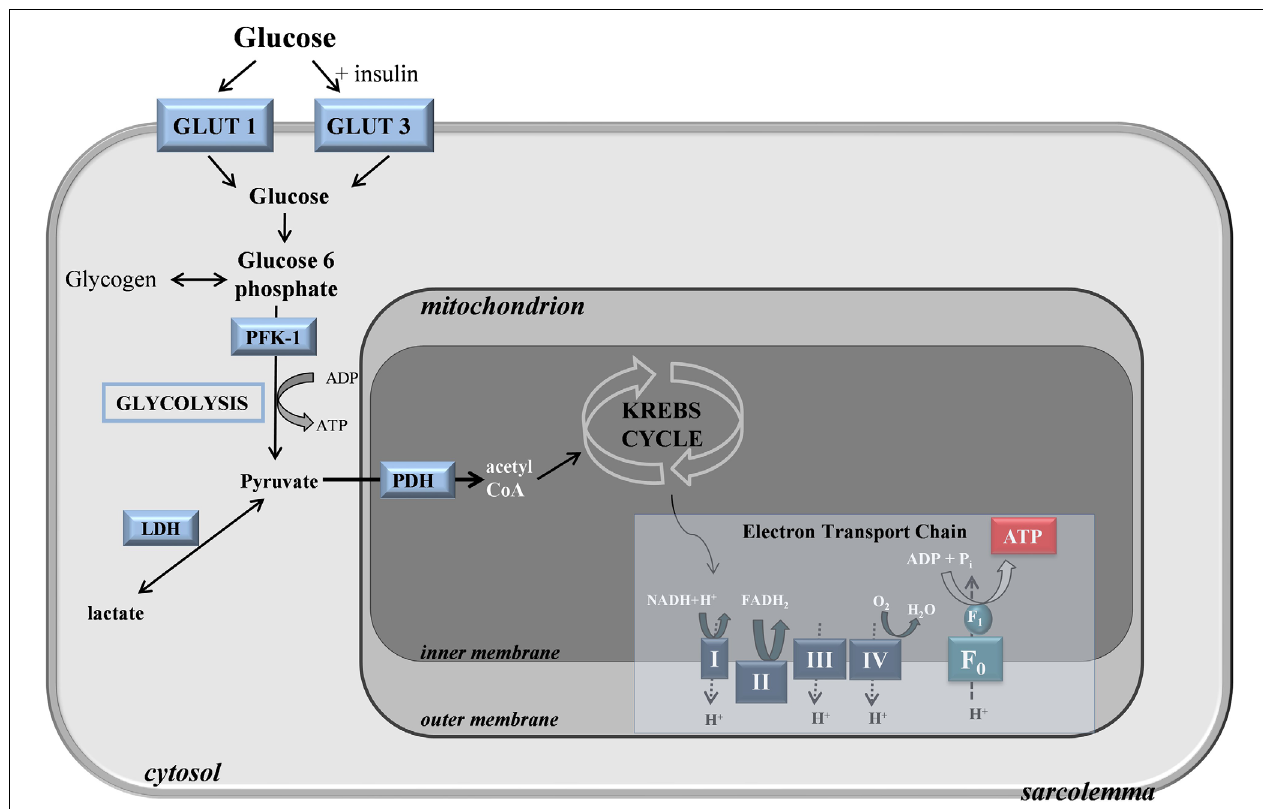
FIGURE 1 | Glucose transport and metabolism in the